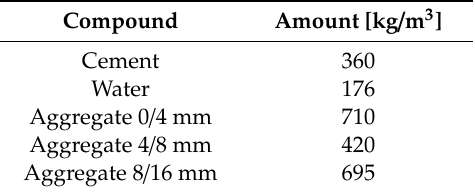
Table 5. Concrete standard mixture for comparison of produced cement types.